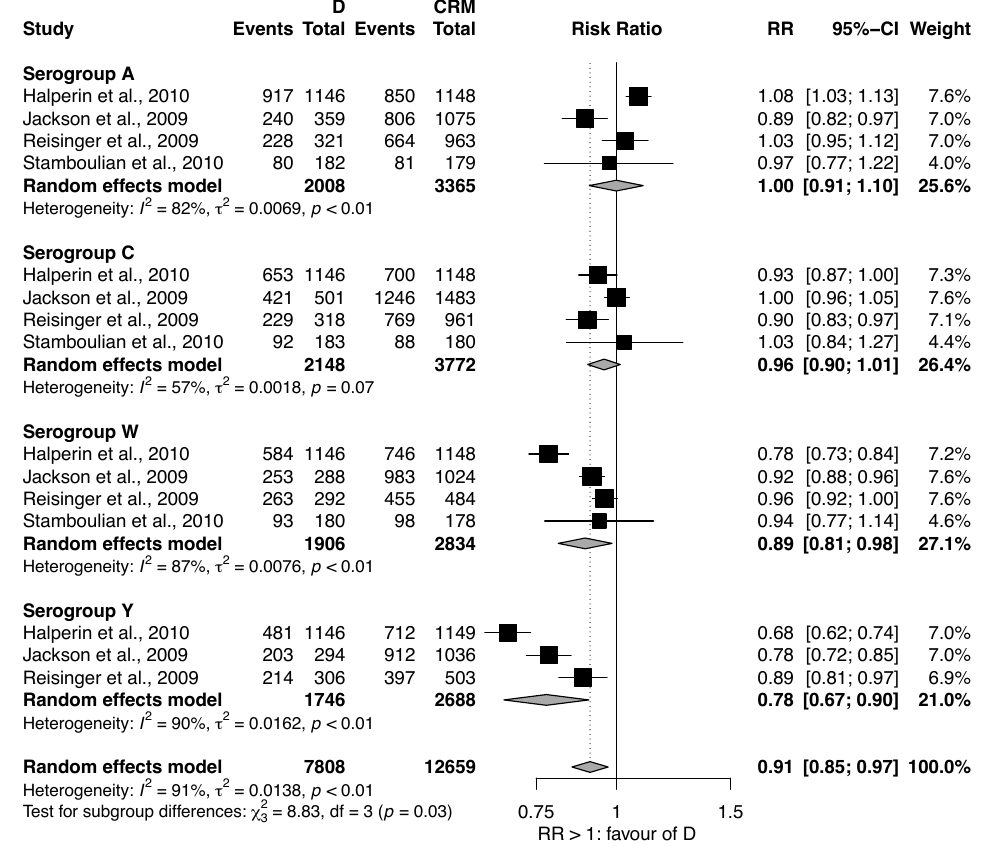
Figure 3. Efficacy of MenACWY-D vs. MenACWY-CRM [23,25,30,31].